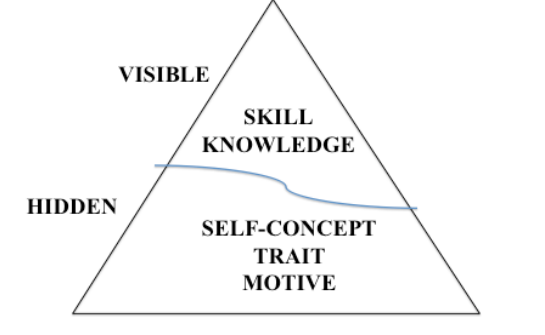
Figure 1. Iceberg Model (modified by L.M. Spencer, & S.M. Spencer,